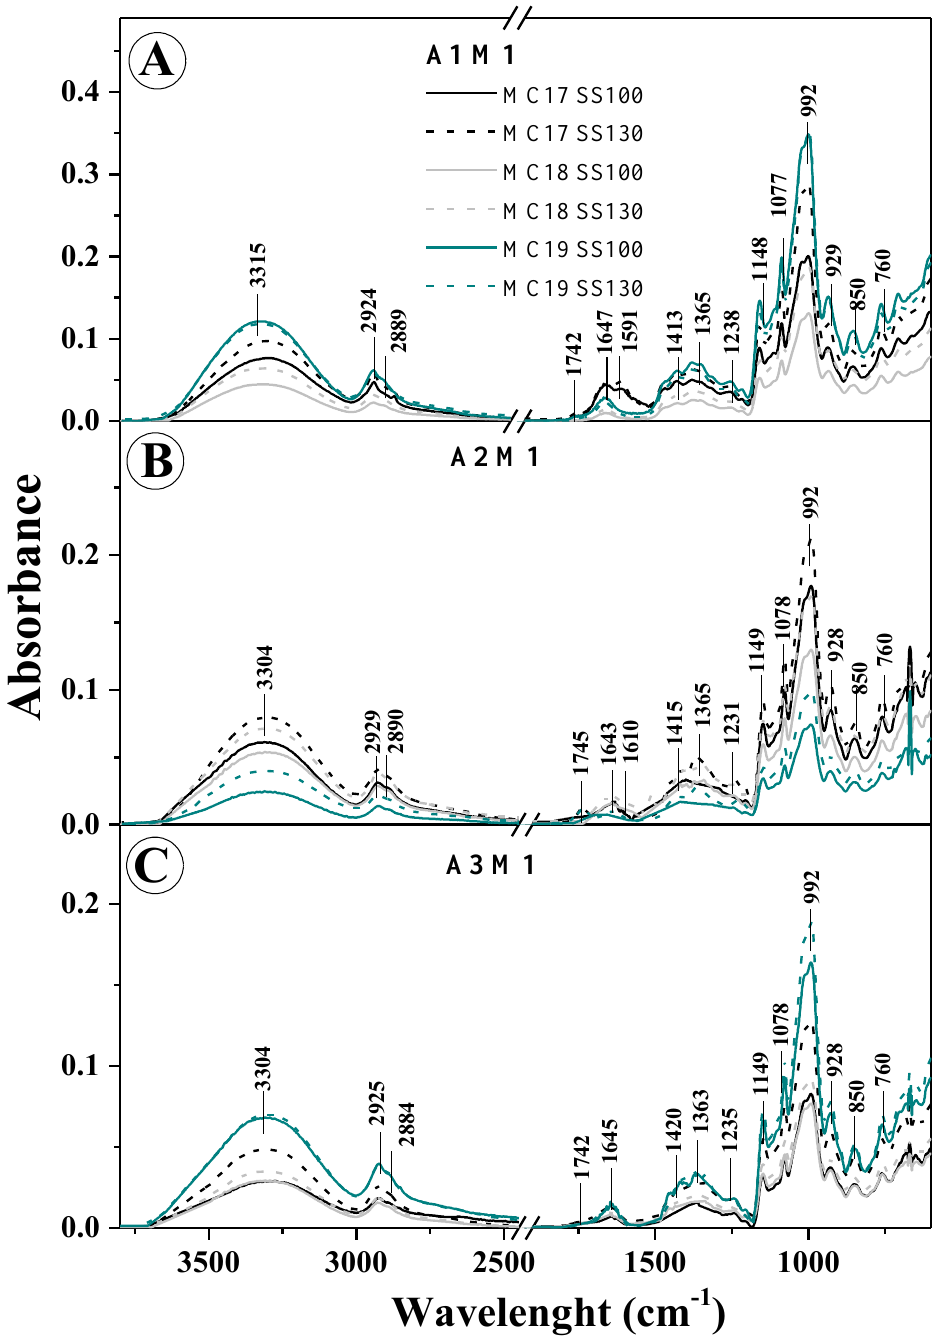
Figure 7. M1 extrudate with different PVA content, panel ( A )—A1, panel ( B )—A2 and panel ( C )—A3. Table 6. Location of peaks of FTIR absorption spectra with the corresponding vibrations for materials selected for tests (biodegradable) over the 3800–550 cm −1 spectrum range.